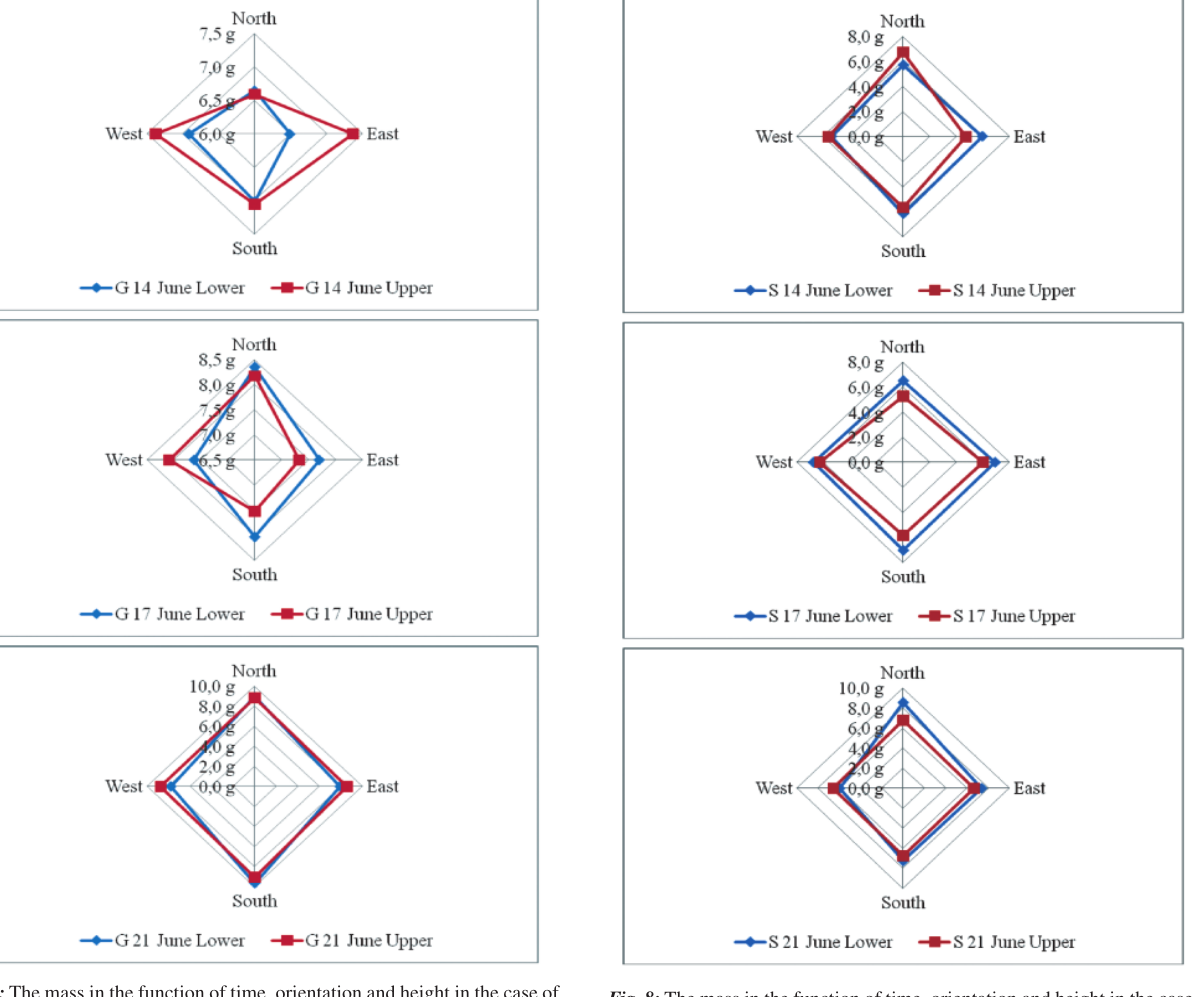
Fig. 8: The mass in the function of time, orientation and height in the case of Stella [g]